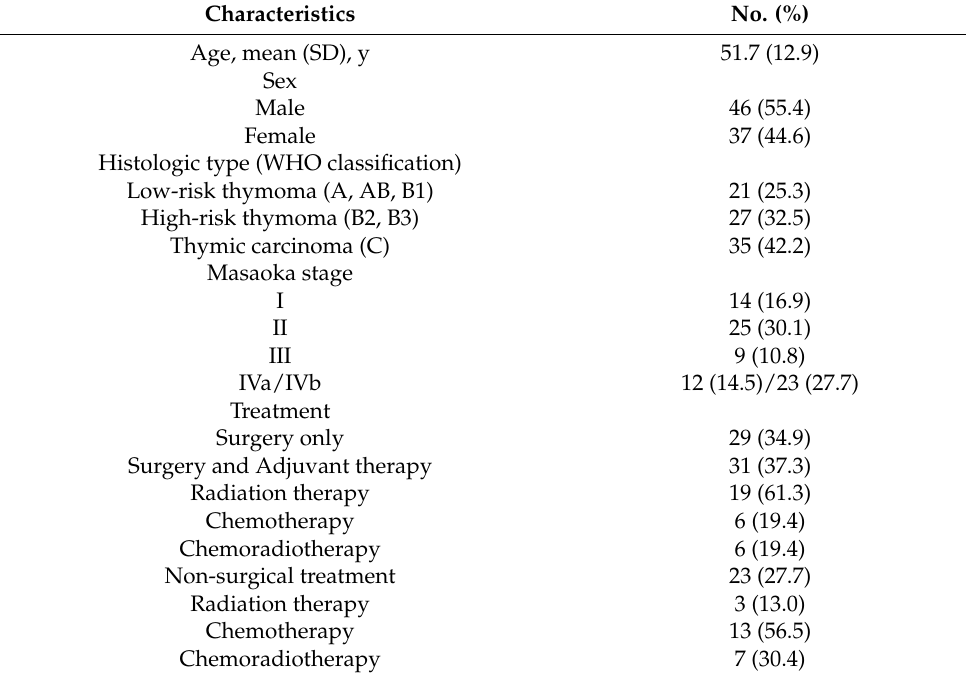
Table 1. Patient demographics and clinical characteristics ( n =